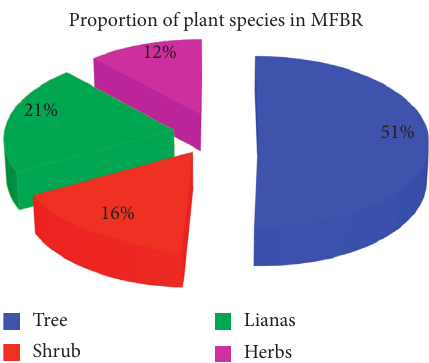
Figure 4: Proportion of plant species of MFBR in different